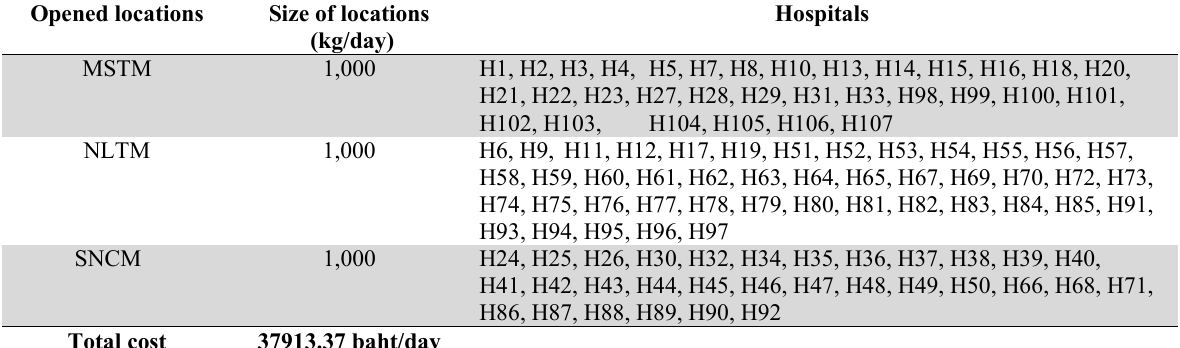
Optimal solution of HGP